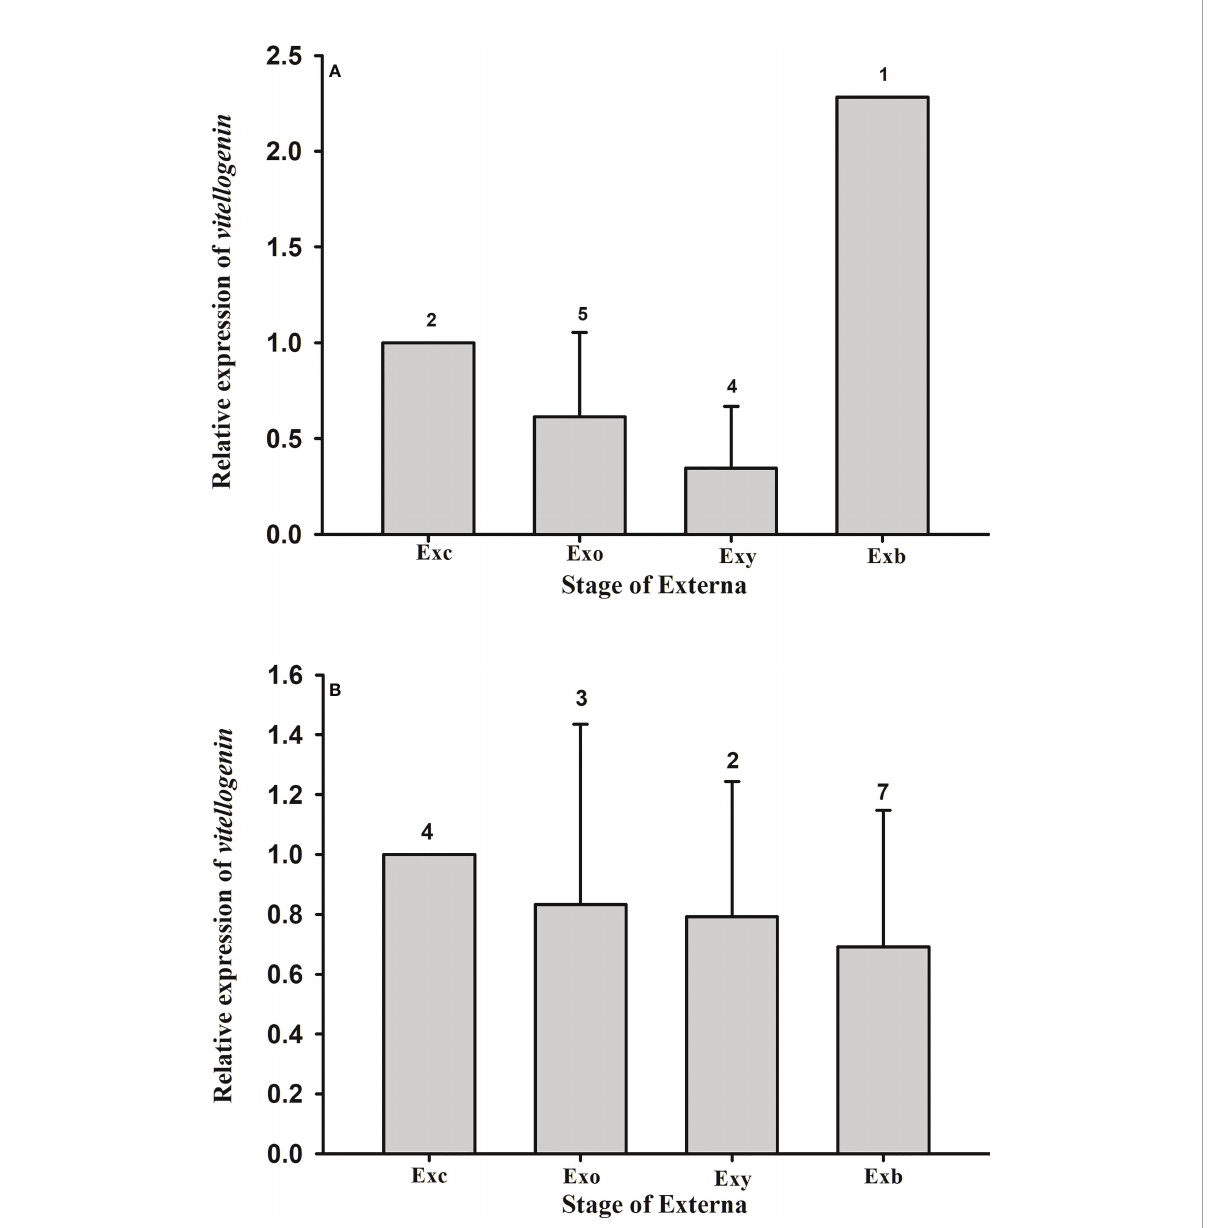
FIGURE 9 Expression pro fi le of vitellogenin gene in the externa of Polyascus planus parasitizing the thukuhar shore-crab ( Metopograpsus thukuhar ). Total RNA prepared from the externae on the (A) male or (B) female hosts was reverse transcribed and the cDNA ampli fi ed with primers as speci fi ed in the Materials and methods. Transcript levels in the externae of various developmental stages were quanti fi ed by the real-time PCR. Transcript levels are normalized to the reference gene (actin) and expressed relative to the levels of Exc, the calibrator stage (Exc = 1). Developmental stage of the externa: Exc, Exo, Exy, and Exb indicate externa of the Creamy, Orange, Yellow, and Brown stages, respectively. Number above the columns indicates the sample